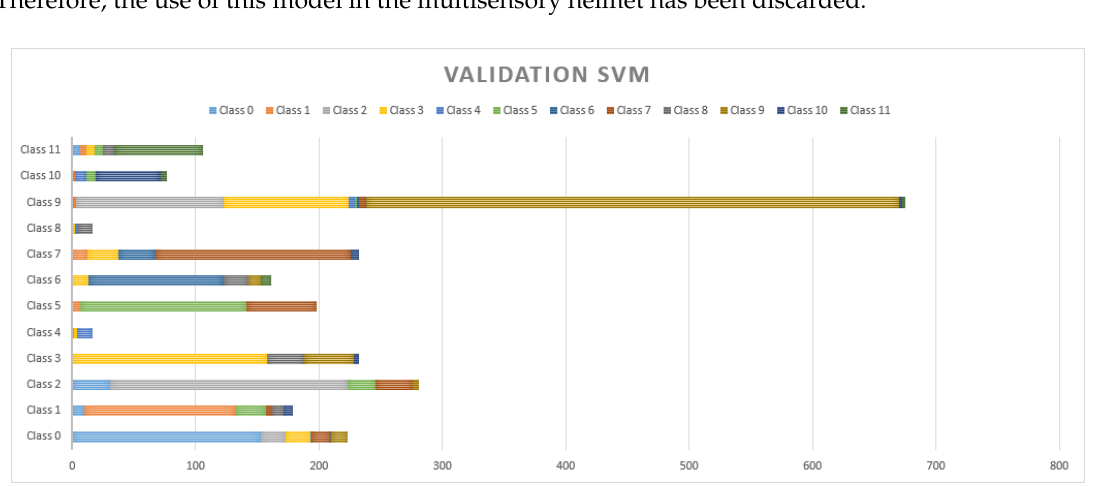
Figure 9. Cross-validation results with 20% for the SVM.